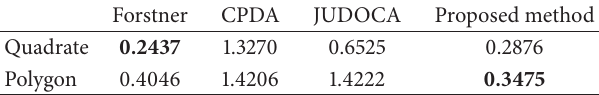
Table 2: The mean error of the junction points’ position among the Forstneralgorithm,CPDA,JUDOCA,andourproposedmethodfor the quadrate image and polygon image (unit: